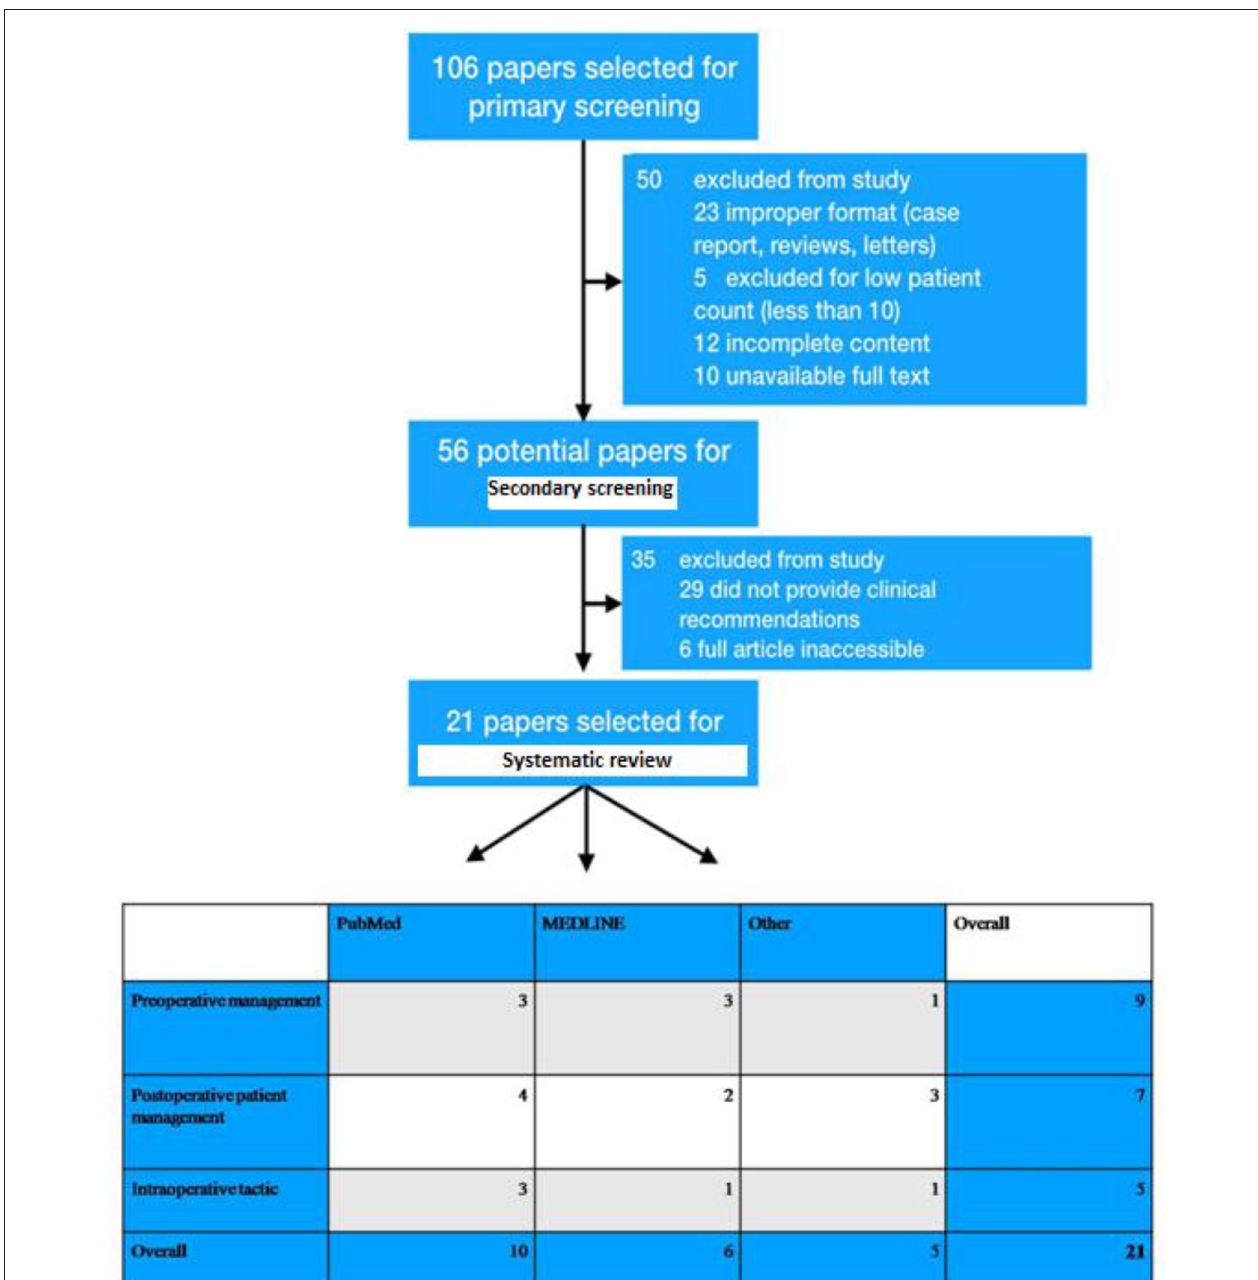
FIGURE 1 | Depiction of exclusion and inclusion criteria of patients who were undergone breast reconstruction and total 106 papers were primarily screened with respect to actuality, publication date, access to article text, content, number of patients, and complete flap-loss rate. Primary screening was executed and selected 56 research papers for secondary screening. Consequently, a two-stage screening process was performed and selected 21 research papers for this